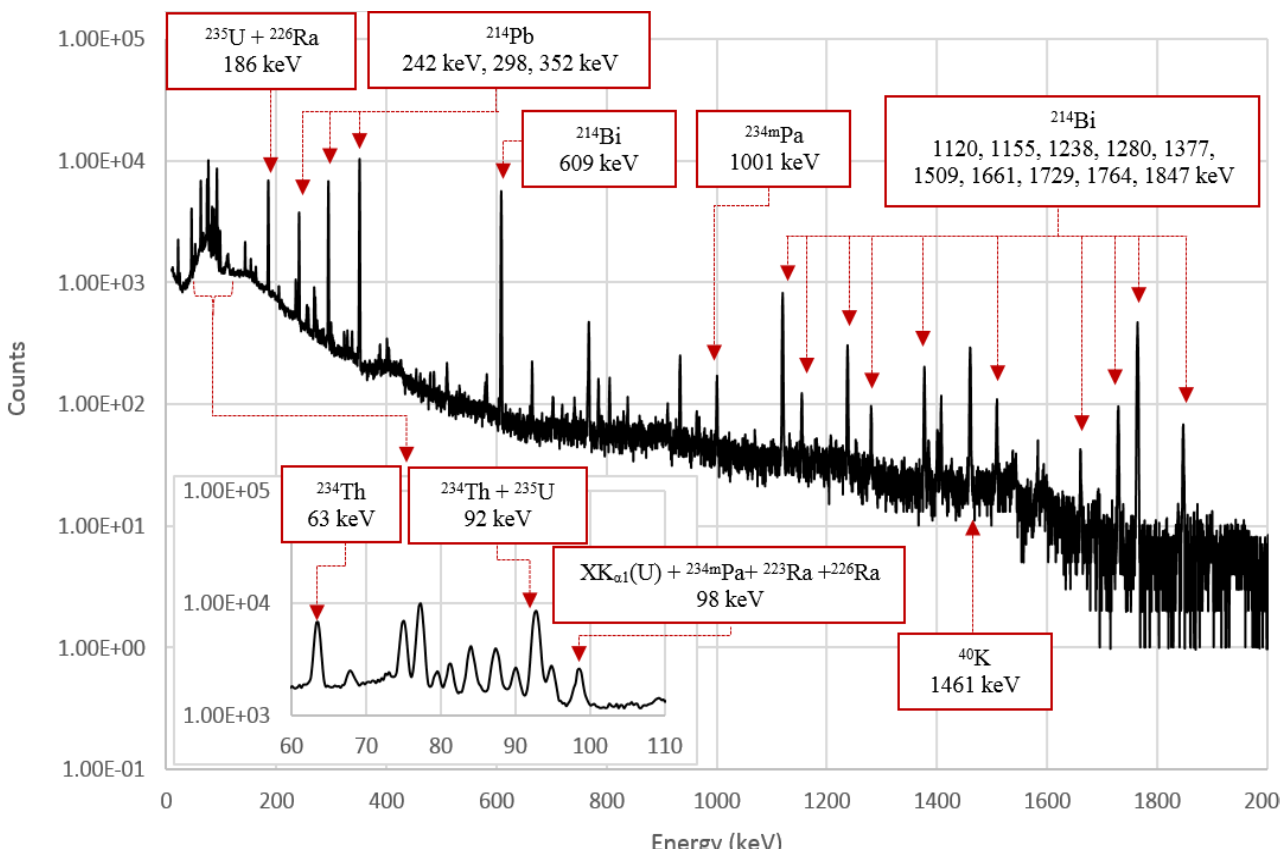
Fig. 1. Experimental spectrum of a 479 g ore sample with an uranium concentration of 419 ppm U and a density of 1.46 g.cm -3 with for 7503 seconds of